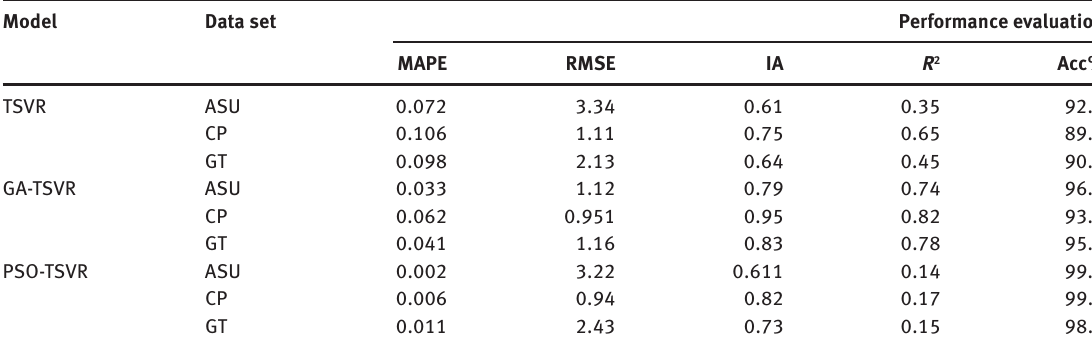
Table 2: Summary of TSVR, GA-TSVR, and PSO-TSVR Experimental Results. Model